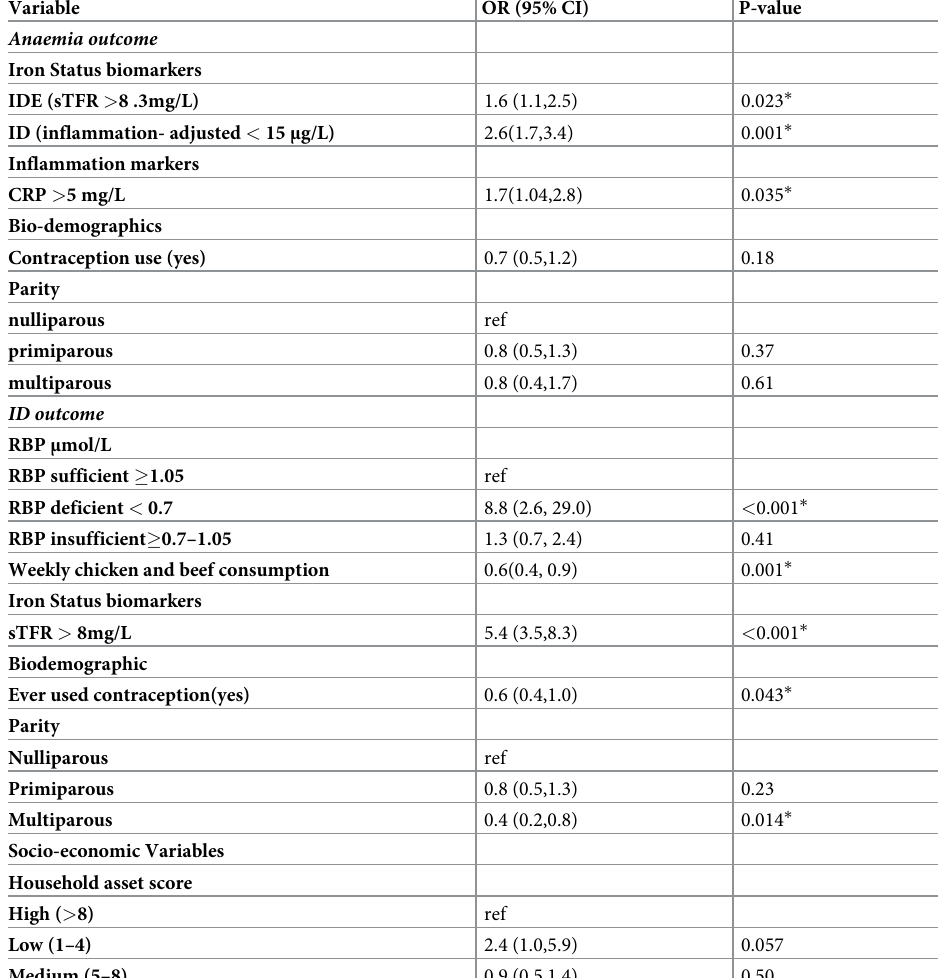
Table 2. Multivariable logistic model of factors associated with anaemia and ID in non- pregnant WRA in Soweto South Africa (n = 480).